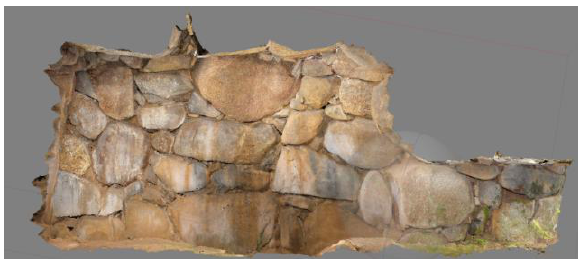
Figure 5. 3D model of the stone chamber in the Bentenzuka burial mound by SfM (Textured).